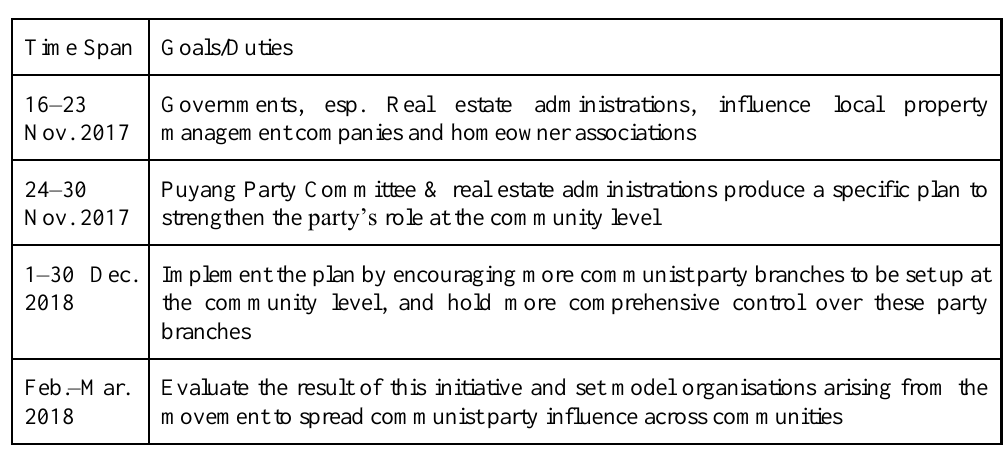
Table 1. Local Government’s Four-step Interference with Community Affairs Source: Hualong District Government,